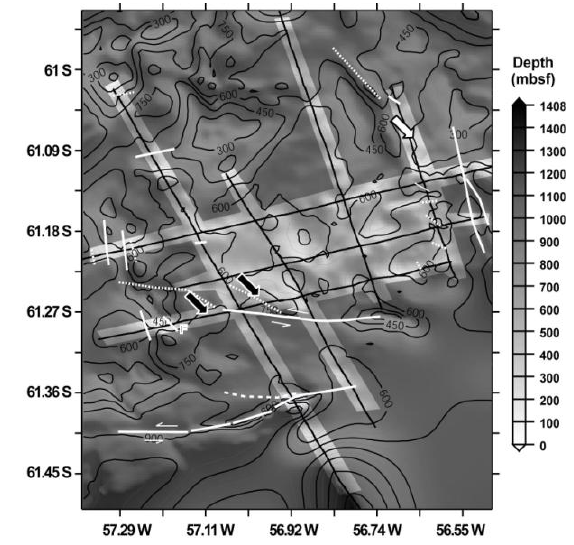
Figure 8. Seismic potential gas hydrate thickness expressed in mbsf. Contour lines are plotted every 75 m. Black arrows indicate the higher and white arrow indicate the lower BSR depth detected within the reservoir. A mask is over-imposed on the images to visualize the reliable data. The structural interpretation was over-imposed as white solid and dashed lines.